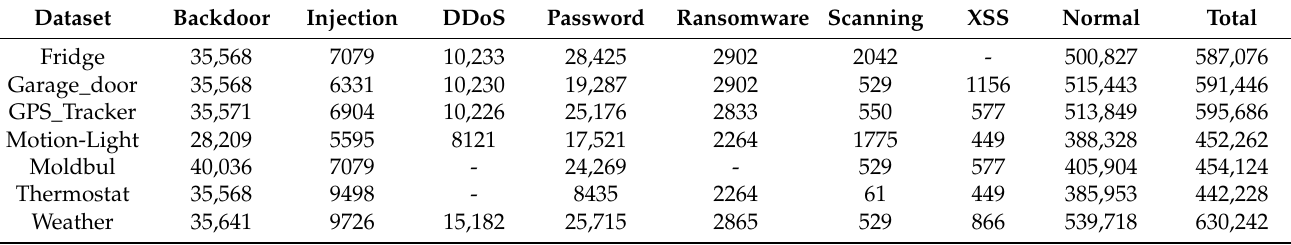
Table 2. Record of the multi-class label of various actual attacks and